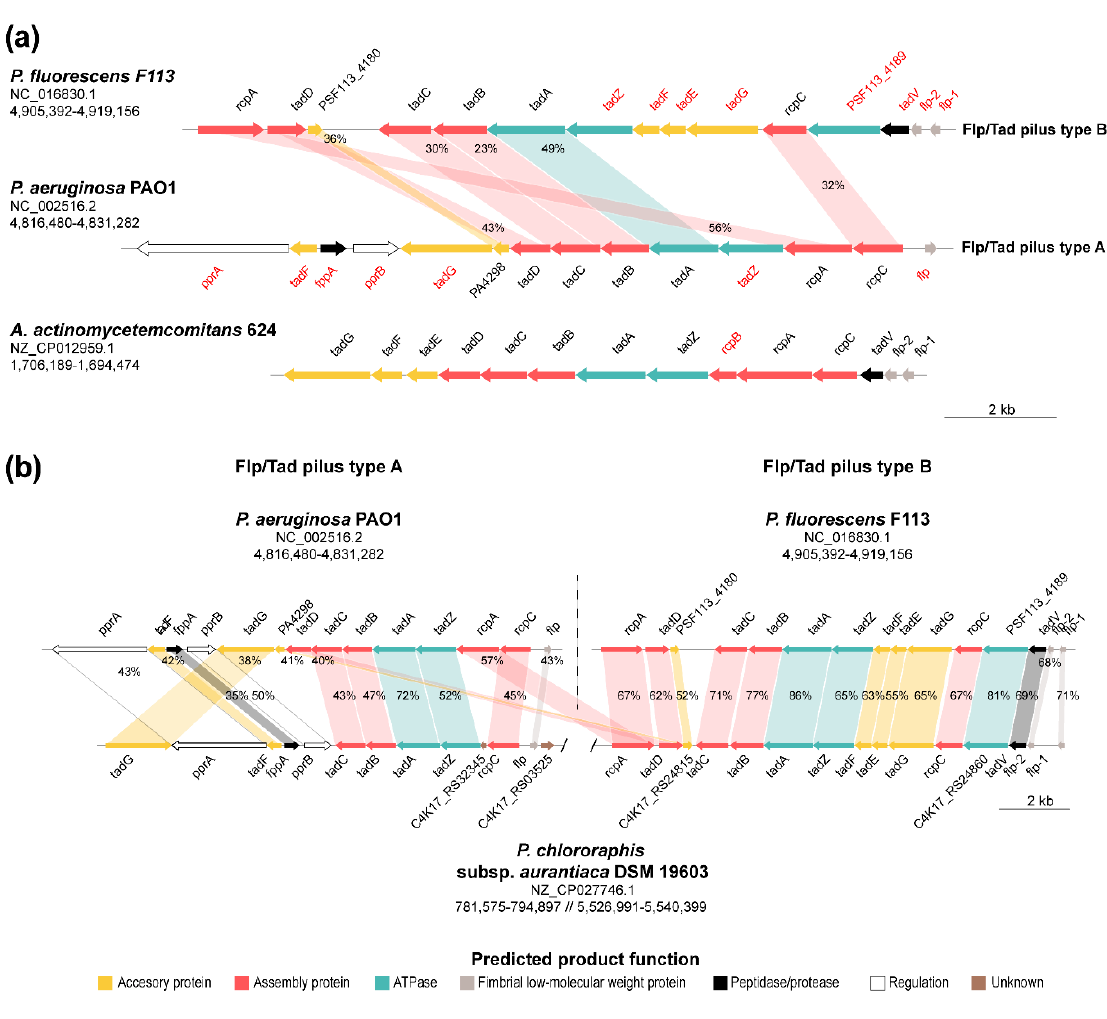
Figure 6. Synteny and sequence identity of flp/tad type A and B gene clusters. ( a ) Gene organization of P. fluorescens F113 (type B), P. aeruginosa PAO1 (type A), and Aggregatibacter actinomycetemcomitans 624 flp/tad gene clusters. Genes typed in red are specific of types A or B Flp/Tad pilus encoding clusters and therefore are not orthologous. ( b ) Synteny of the flp/tad clusters type A ( P. aeruginosa PAO1) and B ( P. fluorescens F113) with P. chlororaphis subsp. aurantiaca DSM 19603, harboring both clusters encoded in its genome. Arrows indicate the relative location, size, and direction of transcription of ORFs. Arrow colors depict the predicted gene product function as shown in the legend. Colored areas indicate genes belonging to the same OG and percentages depict amino acid sequence identity. NCBI access numbers and genomic coordinates of the regions shown are specified under the species names. Genes are scaled.